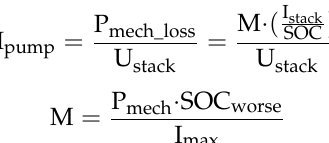
Figure 4. Pump loss model of zinc–nickel single-flow battery stack